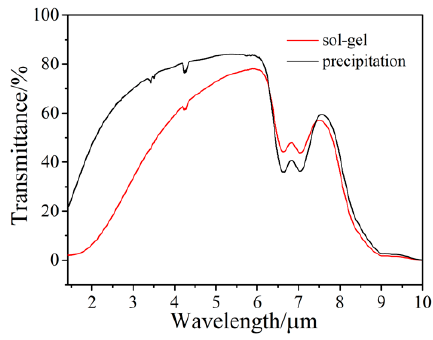
Figure 6. IR transmission spectra of the sintered nanocomposite ceramics with nanocomposite powders with two methods (the thickness of the sample is 2.0 mm).